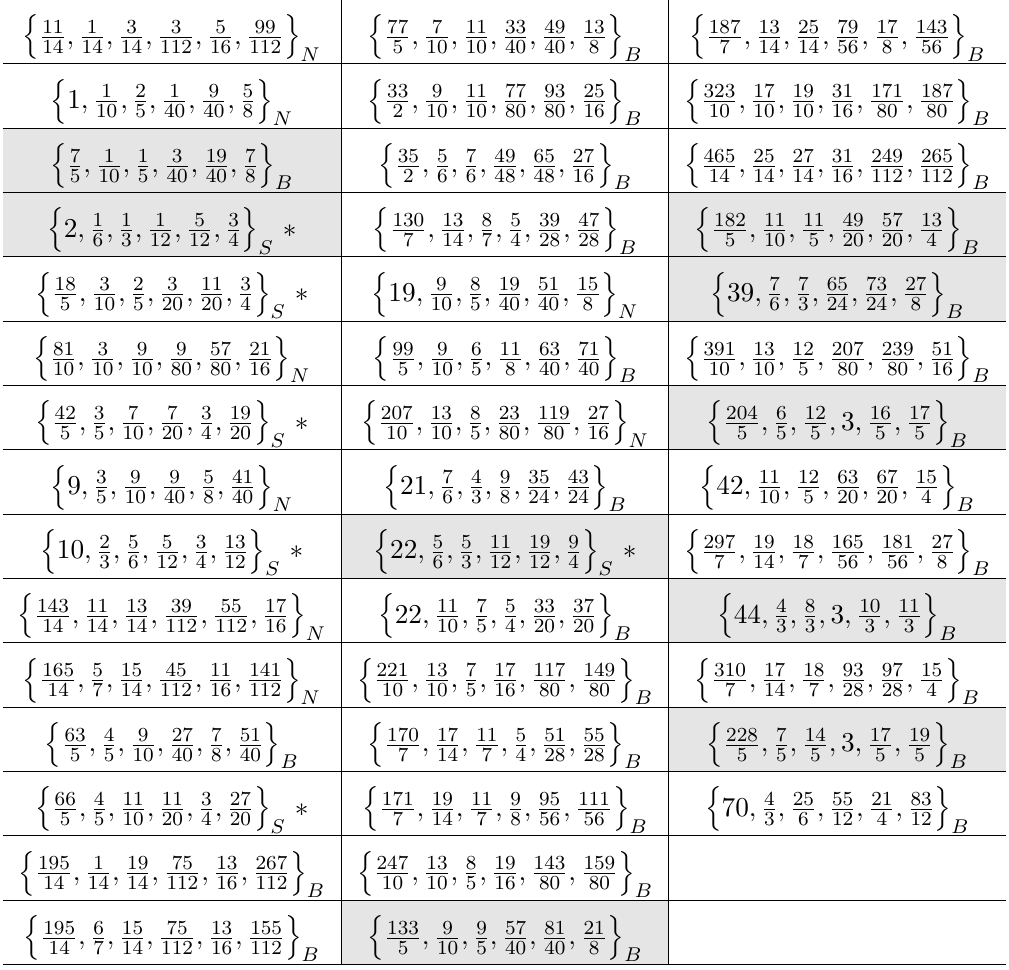
Table 5 . Rank 3 non-degenerate unitary theories with ‘ = 0 . Type: S=SUSY, B=SUSY Broken, N = non-SUSY. We highlight the theories that are a product of lower rank theories. Theories with asterisk are discovered in